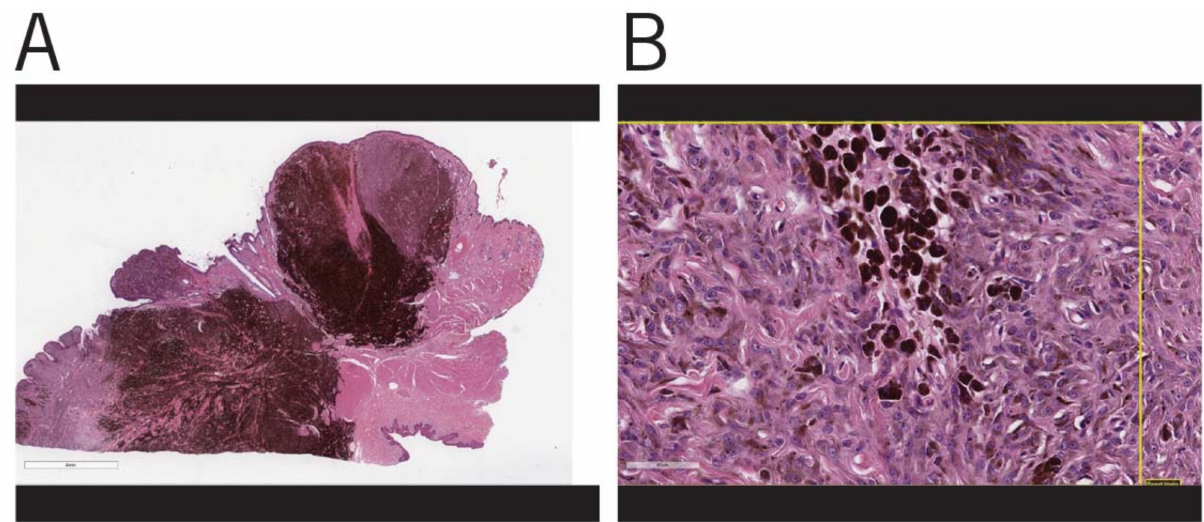
Figure 3. Histopathologic features of HWDMN: ( A ) Heavily pigmented pedunculated mass at mucocutaneous junction with early submucosal extension. Bar = 4 mm; ( B ) Areas of heavily pigmented tumor cells adjacent to less pigmented tumor cells. Nuclei are mildly pleomorphic, oval and have prominent nucleoli, but no mitotic figures. The area framed by the yellow lines denotes the area assessed by the artificial intelligence (AI) software used by Antech diagnostics to calculate MI in addition to manual counts done by the pathologists in the same field as a cross-check. Bar = 60